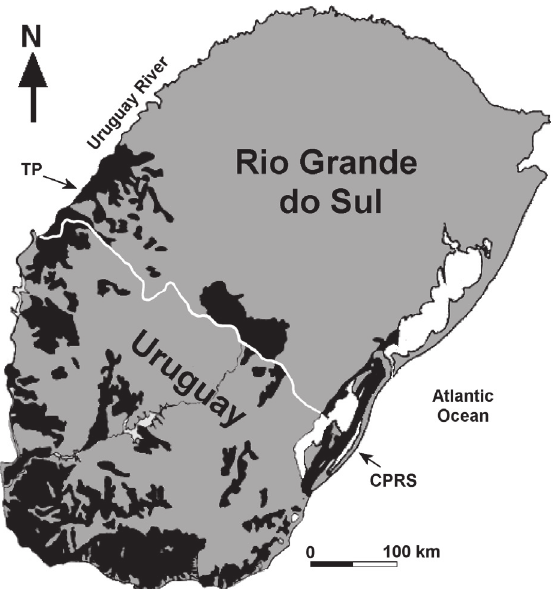
Figure 10 - Distribution of loess deposits in Uruguay (from Panario and Gutiérrez 1999) and soils with CCa horizons (interpreted to be of loessic origin) in Rio Grande do Sul state (from Bombin and Klamt 1974). TP = Touro Passo